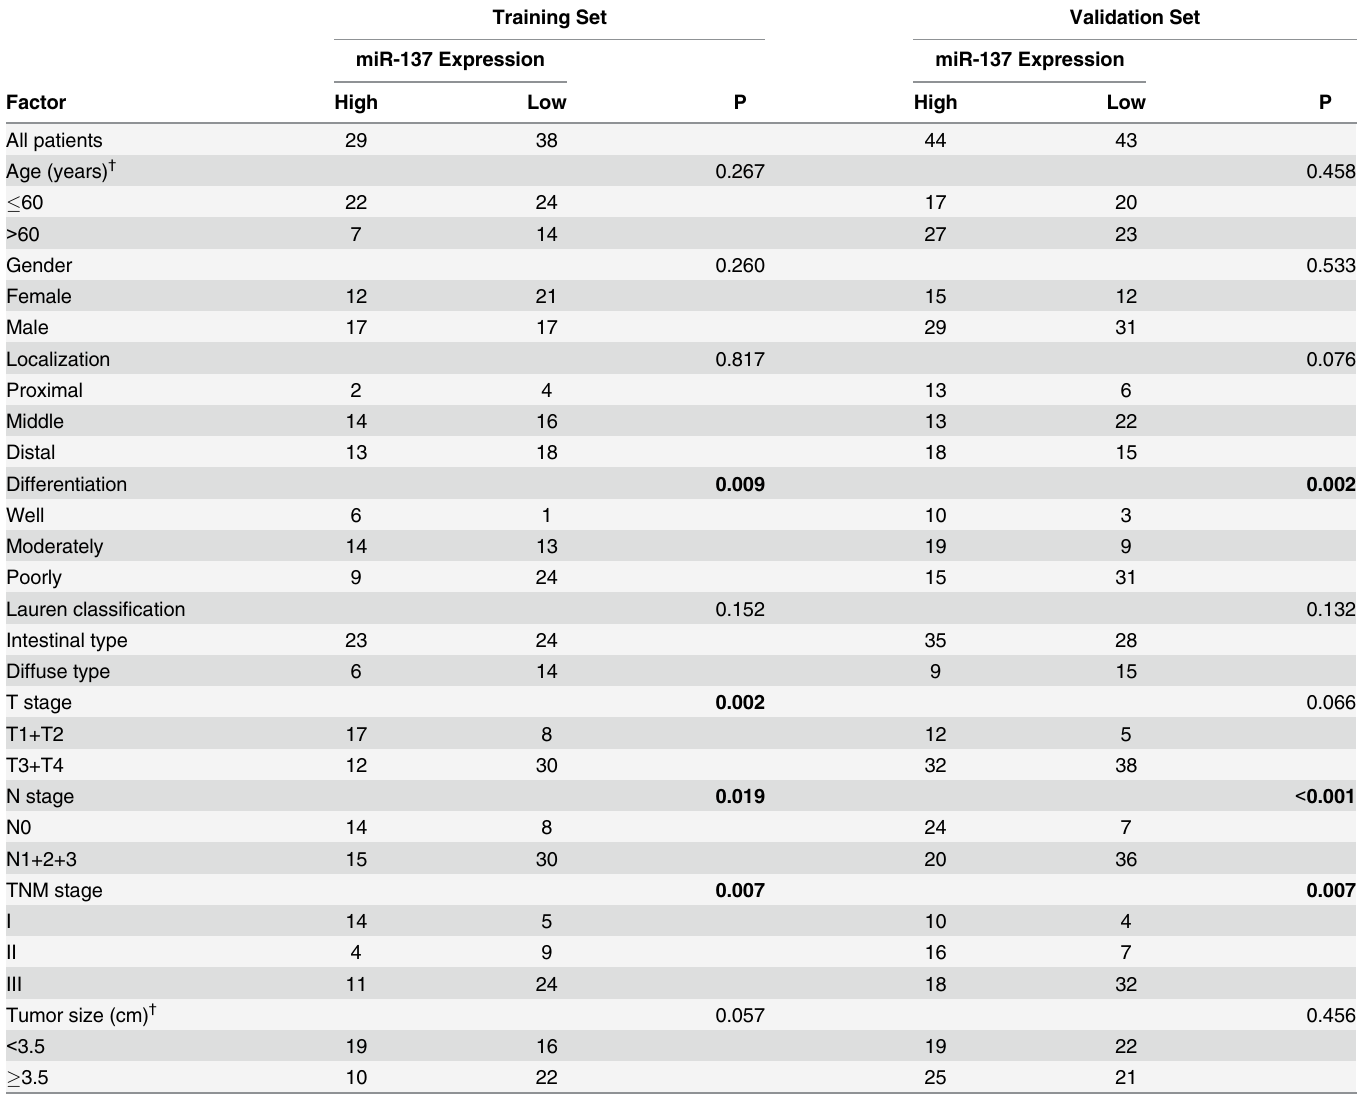
Table 1. Association between miR-137 expression and clinical